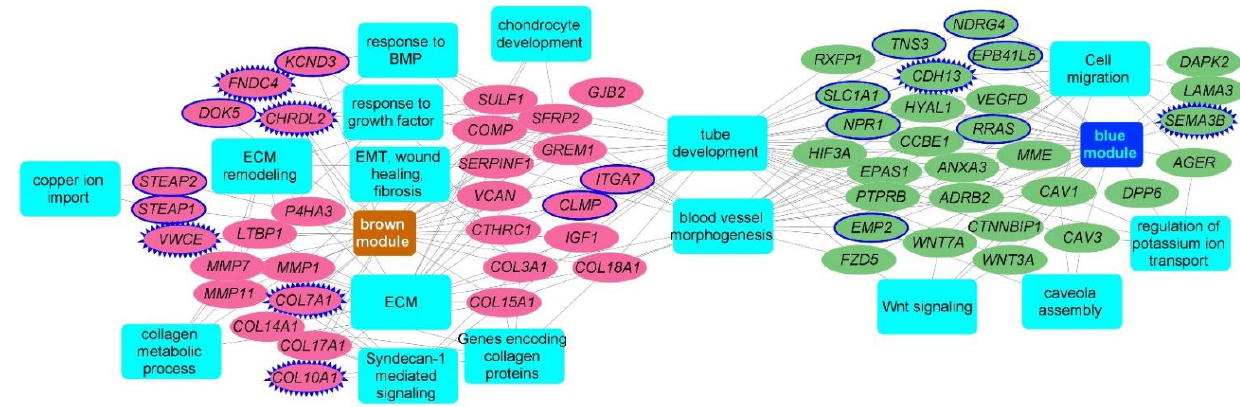
Figure 2. Functional enrichment analysis of hub genes from brown and blue modules. Network representation of select enriched biological processes and pathways among the intramodular hubs from the brown and the blue candidate modules. An edge between a gene (oval node) and a functional annotation (rectangular node) indicates the membership of that gene to that annotation term. Enriched terms are represented as blue color rectangles. Upregulated hub genes of brown module are in pink color while the downregulated genes from the blue module are in green color. Novel fibrotic candidates are highlighted using blue color solid node borders while the secreted novel hubs are highlighted with zig-zag blue borders. Network is generated using Cytoscape